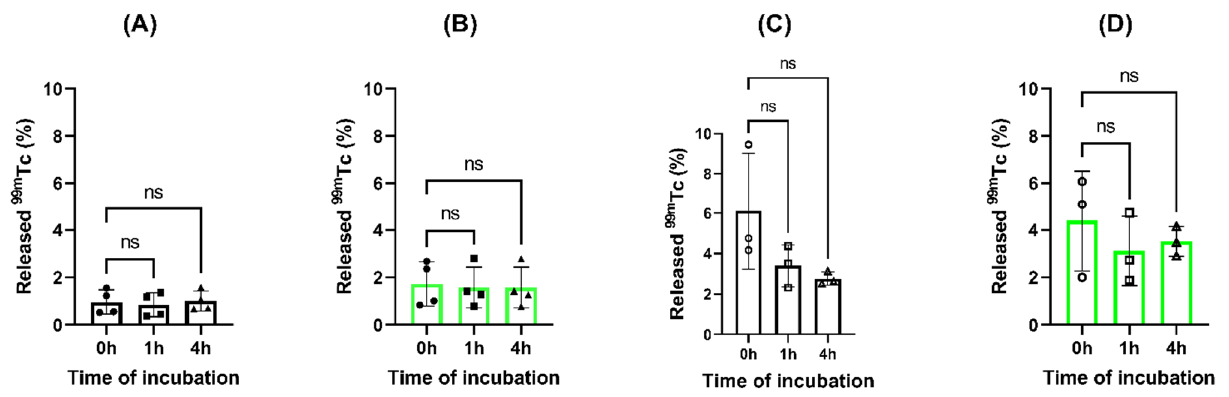
Figure 4. Analysis of released 99m Tc from the loaded nanoparticles during the time of study: ( A ) [ 99m Tc]Tc-SFN in 0.9% NaCl; ( B ) [ 99m Tc]Tc-FITC-SFN in 0.9% NaCl; ( C ) [ 99m Tc]Tc-SFN in blood serum and ( D ) [ 99m Tc]Tc-FITC-SFN in blood serum. ANOVA: n.s., p > 0.05; (n = 3). Table 2. Frequencies of micronuclei, nuclear buds, and nucleoplasmic bridges in human lymphocytes cultured in vitro with radiolabeled nanoparticles by CBMN assay. Sample MNi (‰) Control